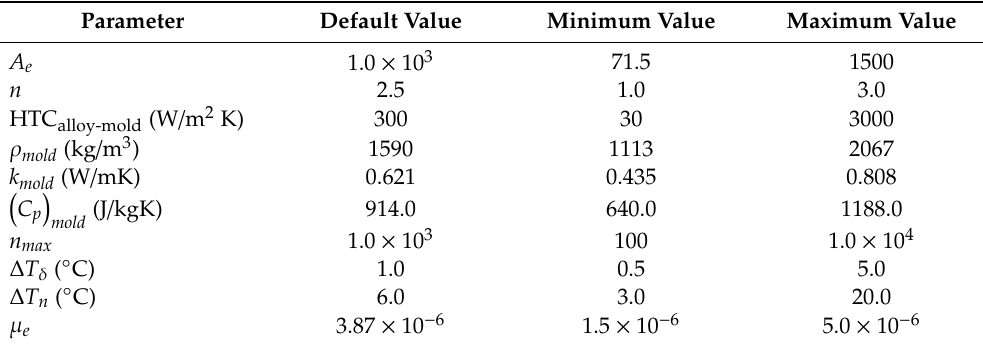
Table 3. Default values and ranges of the variables included in model fitting.